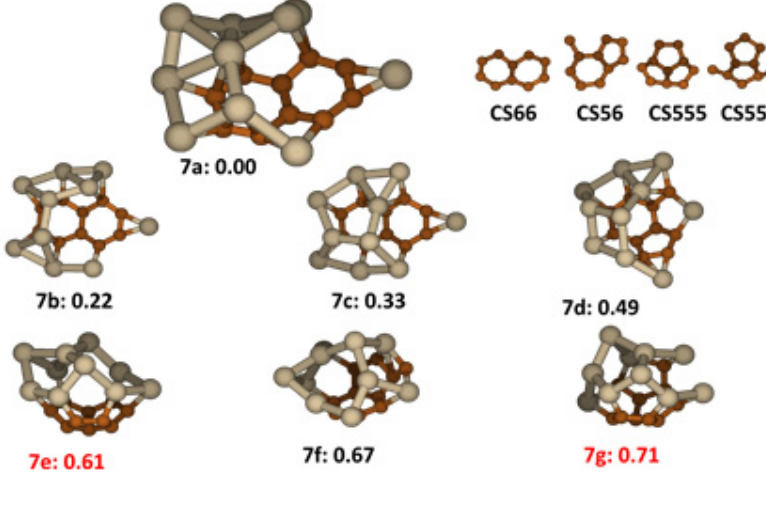
Figure 7. The structures and relative energies (in eV) of the lower energy Si and carbon segregations. Structure 7e and 7g are previously reported in ref. [17] and ref. [21],